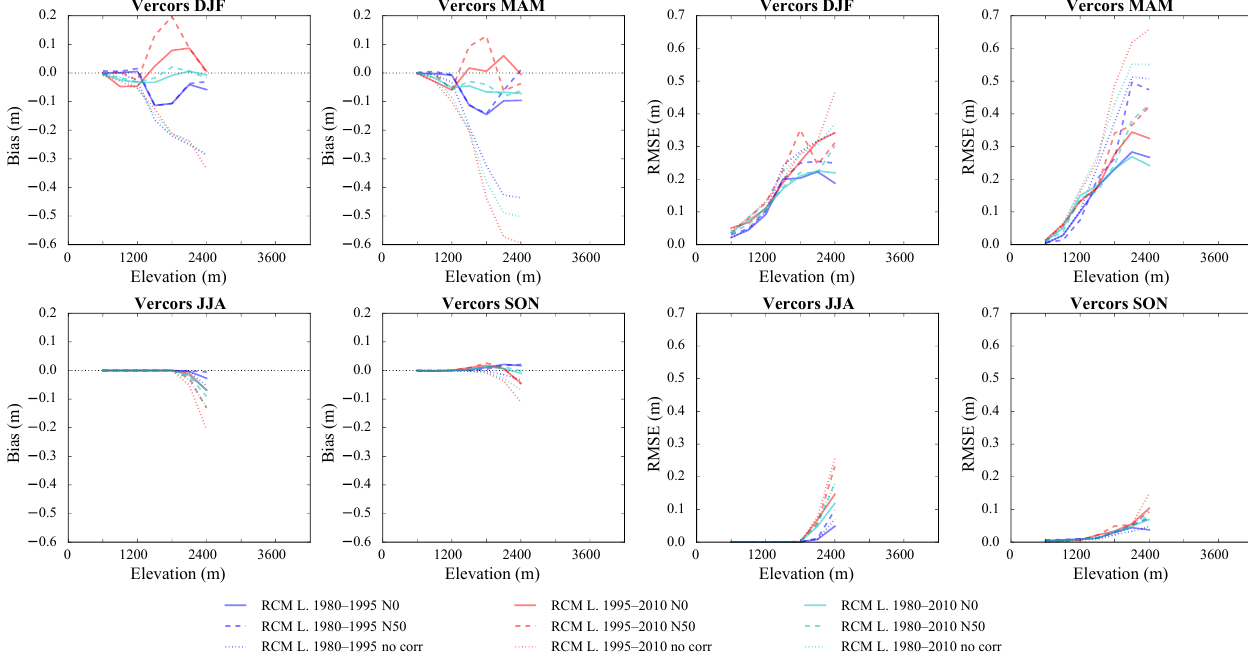
Figure 11 represents the mean annual cycle of temperature, precipitation and snow depth for the different adjusted RCM simulations vs. the SAFRAN/Crocus reanalysis, for the pe- riod 1980–1995 and 1995–2010 for the Vercors massif